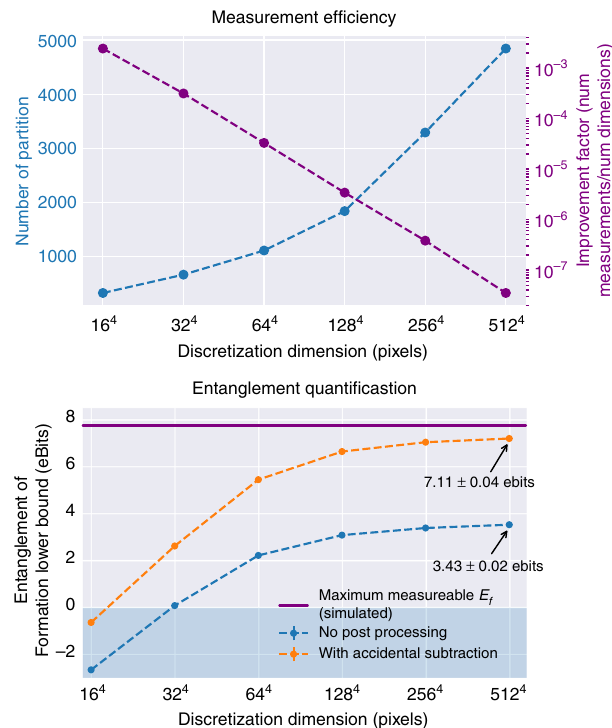
Fig. 4 Entanglement quanti fi cation versus maximum resolution. a shows the number of partitions required as a function of maximum allowed resolution and the improvement over the uncompressed approach. b shows the amount of entanglement captured as the maximum resolution increases. We see the progressive nature of the technique, which witnesses entanglement with few measurements at low resolution but more accurately quanti fi es it with further re fi nement. Our results approach the ideal maximum measurable value E f = 7.68 ebits for our